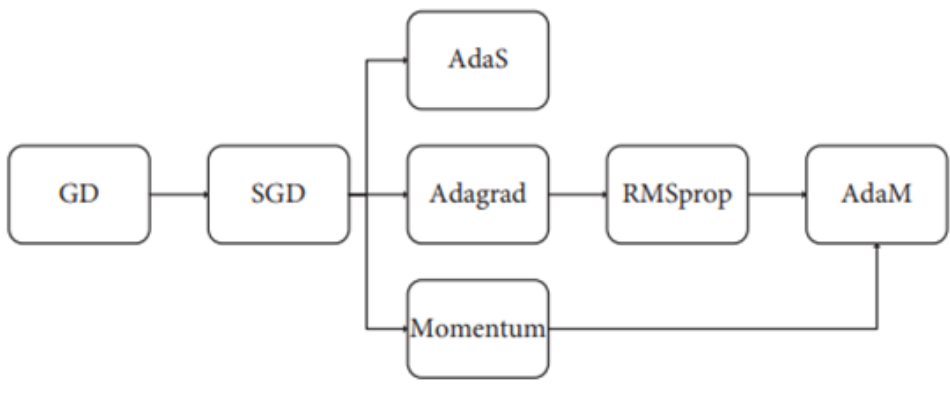
Figure 11. Optimization